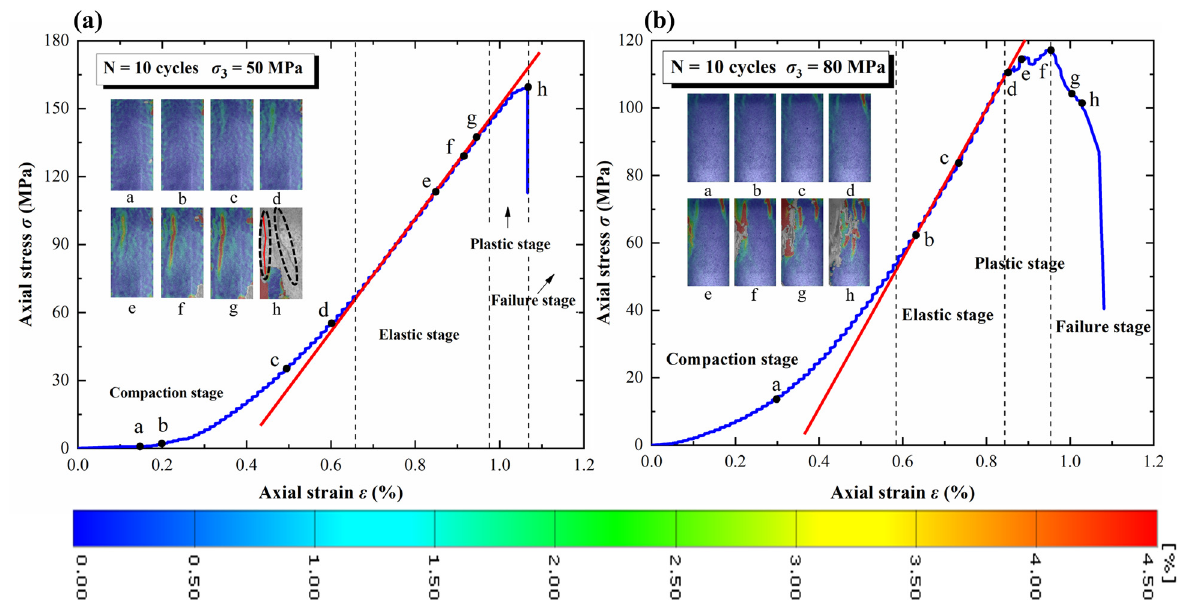
Figure 9. Crack evolution process of pre-damaged specimen after 10 cycles. ( a ) σ 3 = 50 MPa; ( b ) σ 3 = 80 MPa.